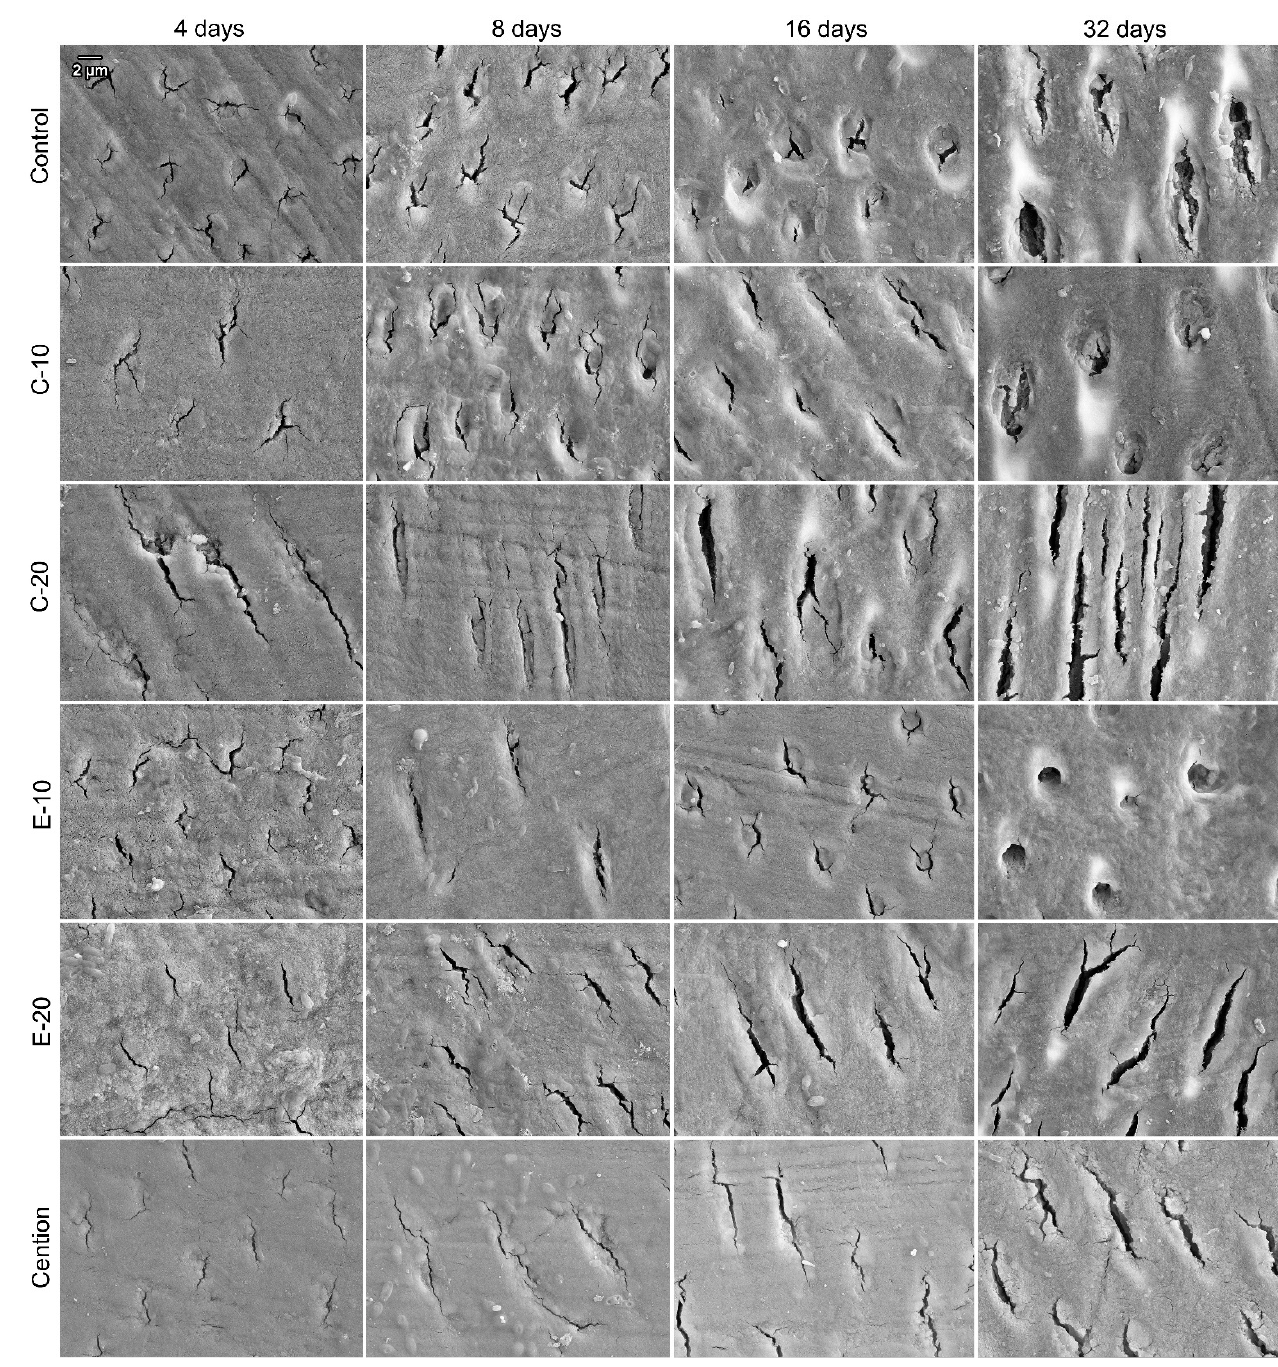
Figure 4. Representative scanning electron microscopy images of dentin surfaces immersed with experimental composites and one of the commercial reference materials (Cention). Due to variations in the direction of dentinal tubules relative to the plane of sectioning, the cross-sections of dentinal tubules range from circular to oblique.